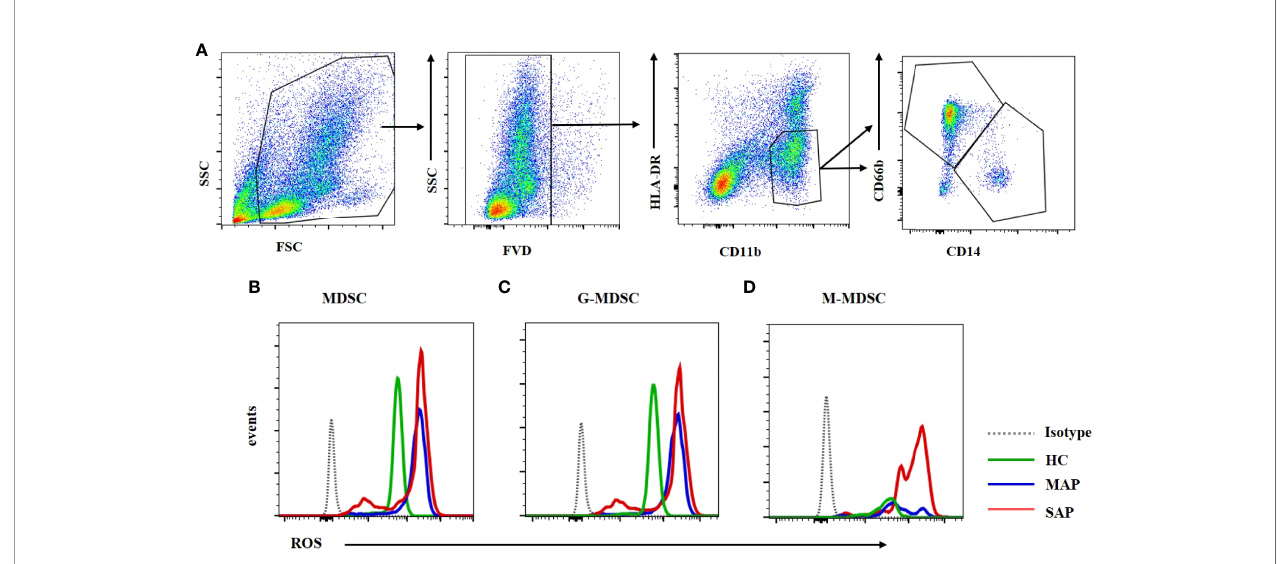
FIGURE 8 | ROS expression in MDSC was enhanced in the MAP and SAP patients compared with HCs. (A) The fl ow cytometry pro fi ling of HLA-DR+CD11b+ MDSCs, CD66b+CD14- G-MDSC and CD66b-CD14+ M-MDSC. ROS expression of MDSC (B) G-MDSC (C) and M-MDSC (D) was increased in patients with MAP and SAP compared with